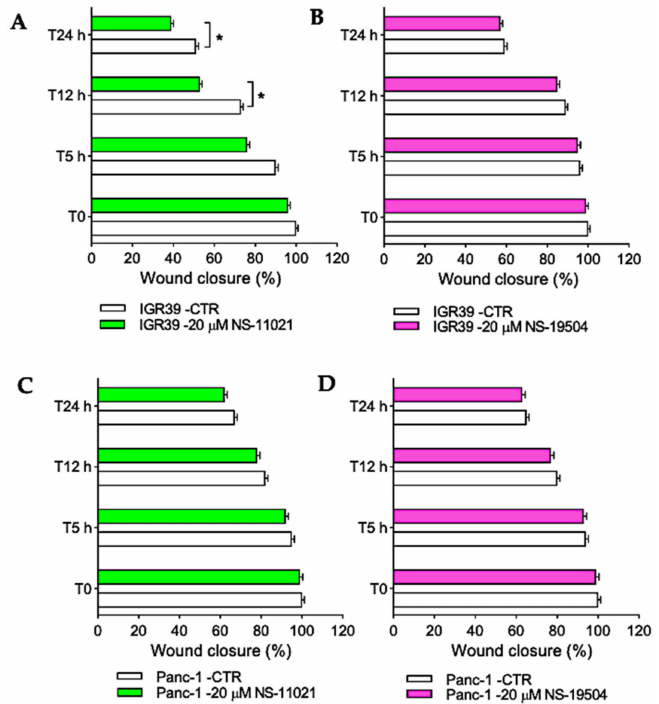
Figure 6. In vitro effects of BK channel openers on cell migration. IGR39 and Panc-1 cells were incubated with 20 µ M NS-11021 ( A , C ) or 20 µ M NS-19504 ( B , D ) for 24 h. The 0.1% DMSO (maximal percentage used in the treatments) was not significantly different versus control; * p < 0.05 versus control as determined by one-way ANOVA followed by Dunnet’s post hoc test ( n =